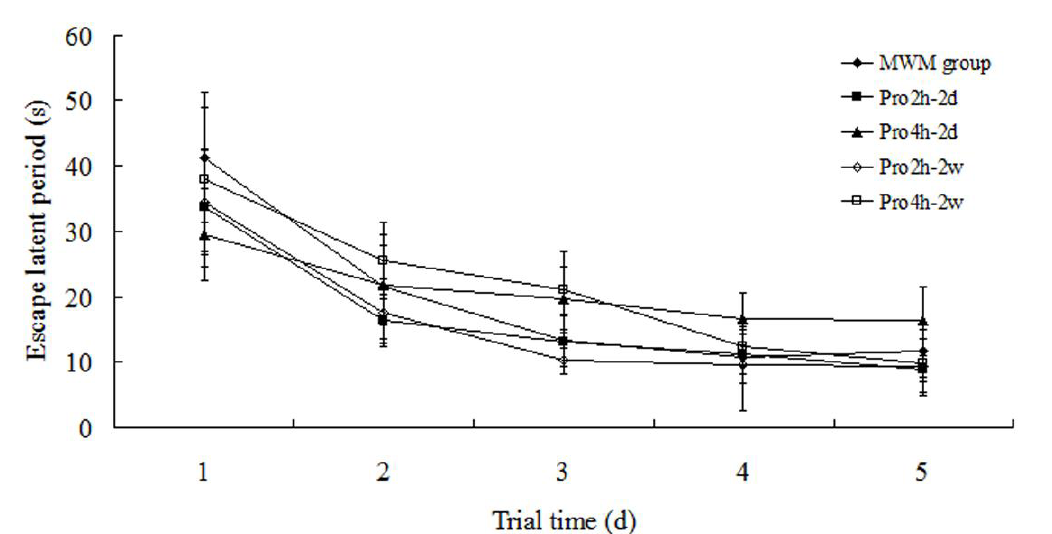
FIGURE 2 - Morris water maze training in aged rats treated with propofol. Comparing with MWM group, the escape latent period of P4h/2d group was significantly increased (P<0.05). The escape latent period was stable until day 4 in P4h/2w group, which means the learning curve was right-shifted (P<0.05). Escape latency in group P2h/2d and P2h/2w was not affected by propofol (P>0.05).